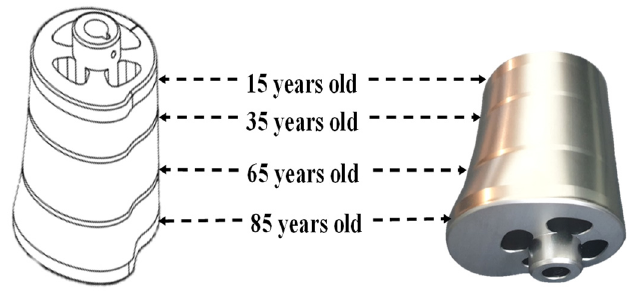
Figure 2. Design and fabrication of the proposed 3D cam.